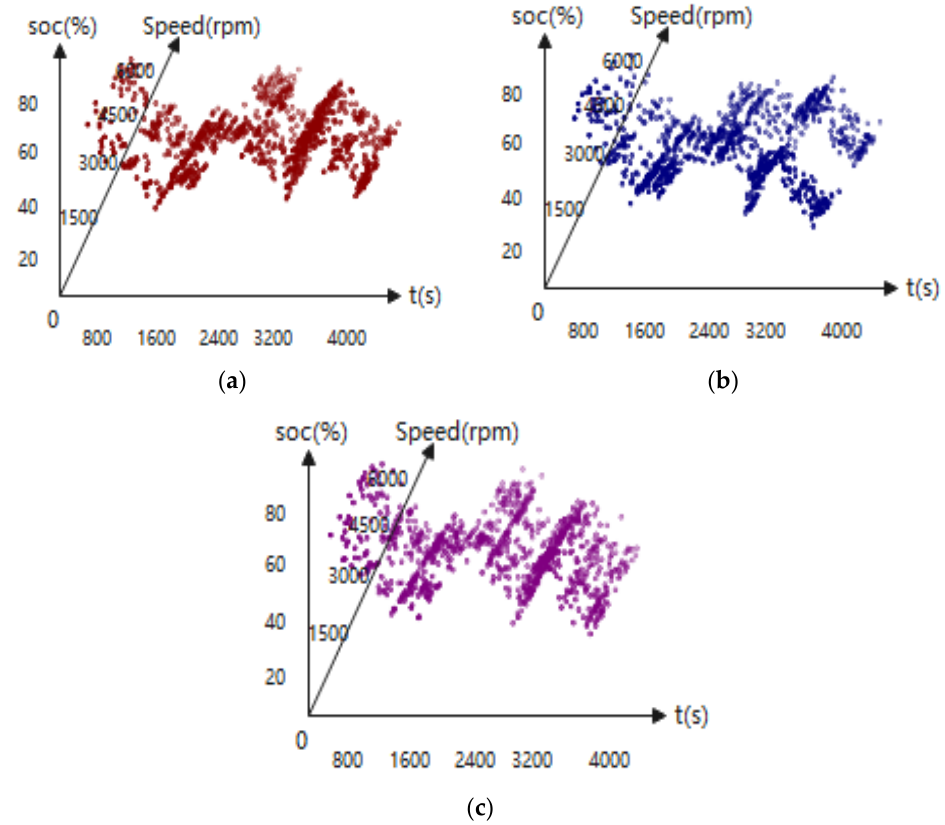
Figure 16. State space distribution of long flight mission: ( a ) S2; ( b ) S1; ( c ) optimal.